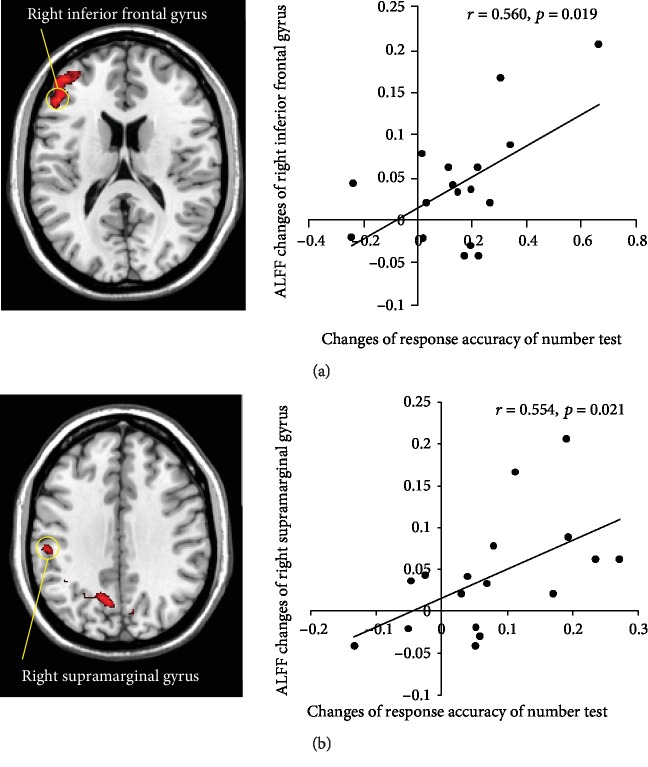
Correlation between the changes of response accuracy and ALFF values. Left view of the figure shows the comparison results of ALFF between rTMS and SD in the right inferior frontal gyrus (a) and right supramarginal gyrus (b). Right view of the figure exhibits the correlation results.